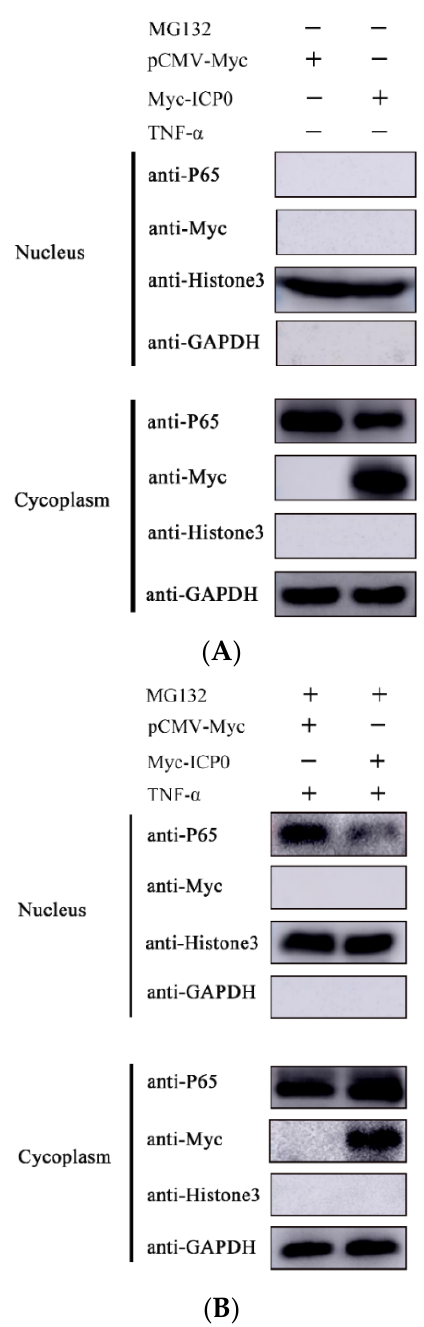
Figure 6. ICP0 protein blocks p65 nuclear translocation. ( A ) PK15 cells were transfected withpCMV- Myc (1.0 µg) or Myc-ICP0 (1.0 µg) for 36 h. Cells were collected without MG132 and TNF- α treat- Myc (1.0 µ g) or Myc-ICP0 (1.0 µ g) for 36 h. Cells were collected without MG132 and TNF- α ment. Cytoplasmic and nuclear proteins were extracted and subjected to Western blot analysis.( B )